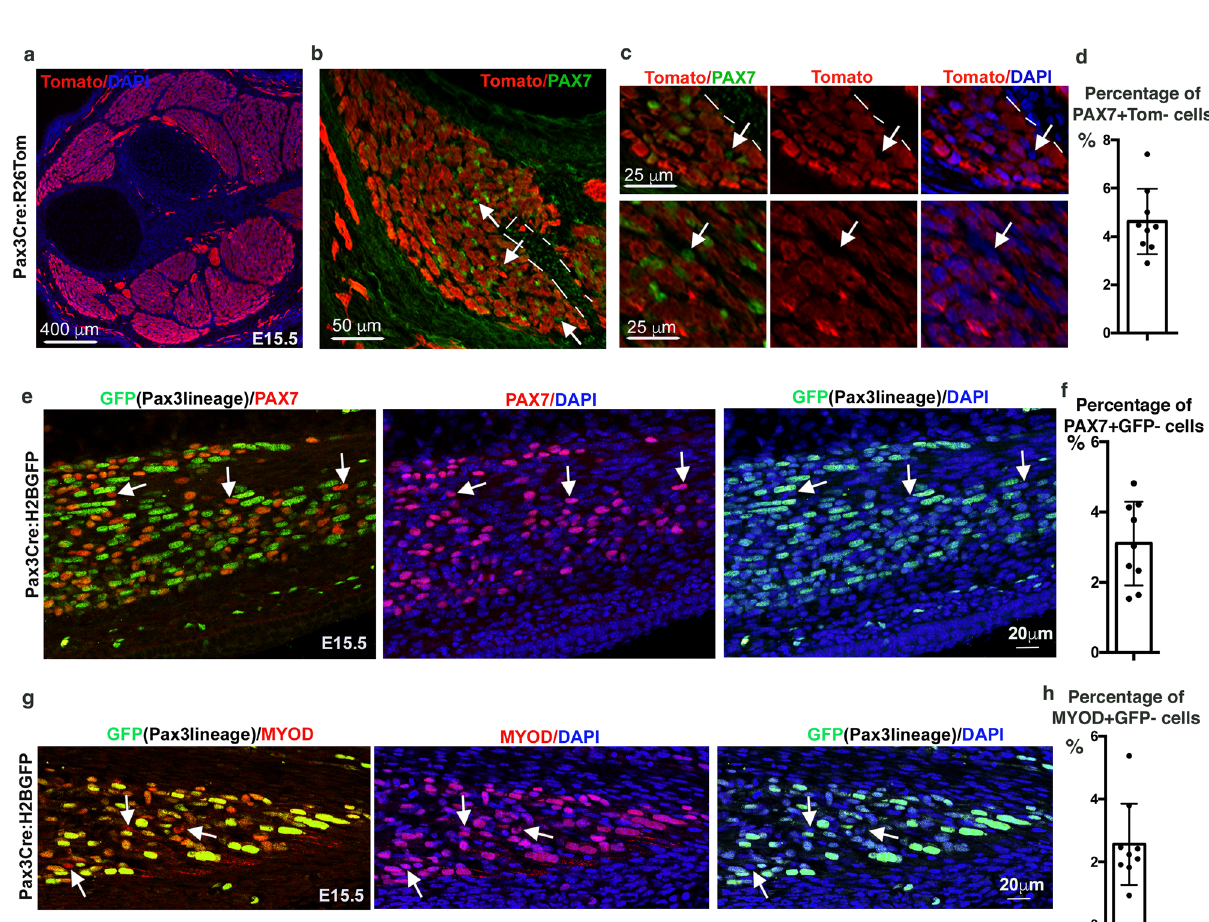
Fig. 2 A subpopulation of muscle cells is not derived from the Pax3 lineage in mouse limbs. a Transverse forelimb sections of E15.5 Pax3 Cre :R26 stop/Tom mice immunostained with Tomato ( Pax3 lineage, red) antibody and DAPI staining (blue). b Focus on a muscle immunostained with Tomato ( Pax3 lineage, red) and PAX7 (green) antibodies. c High magni fi cations showing PAX7 + cells (green) that are tomato-negative, i.e. not of Pax3 lineage (arrows). d Percentage of PAX7 + /Tomato − cells versus PAX7 + cells in muscles. Data are presented as mean values ± SD from 3 limbs. e Longitudinal sections along a limb muscle of E15.5 Pax3 Cre :R26 H2BGFP mice immunostained with GFP ( Pax3 lineage, green) and PAX7 (red) antibodies. Arrows point to PAX7 + cells that are GFP-negative. f Percentage of PAX7 + /GFP − cells versus PAX7 + cells in muscles. Data are presented as mean values ± SD from 3 limbs. g Longitudinal sections along a limb muscle of E15.5 Pax3 Cre :R26 H2BGFP mice immunostained with GFP ( Pax3 lineage, green) and MYOD (red) antibodies. Arrows point to MYOD + cells that are GFP-negative. h Percentage of MYOD + /GFP − cells versus MYOD + cells in E15.5 muscles. Data are presented as mean values ± SD from 3